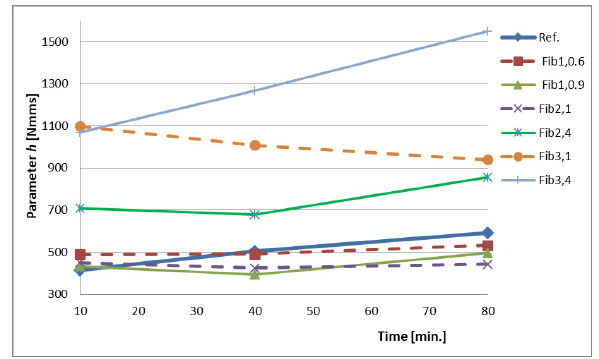
Figure 9: Dependency of the parameter h on fiber type, fiber content and